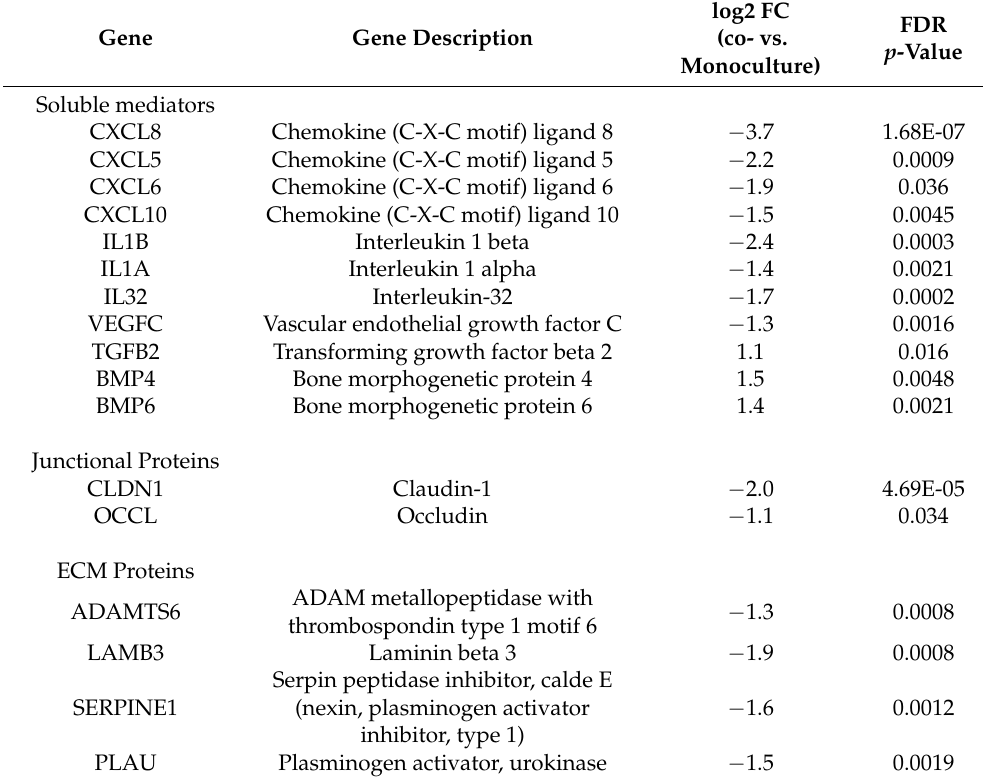
Table 2. List of differentially regulated genes (DRGs) potentially linked to barrier function [23–27].